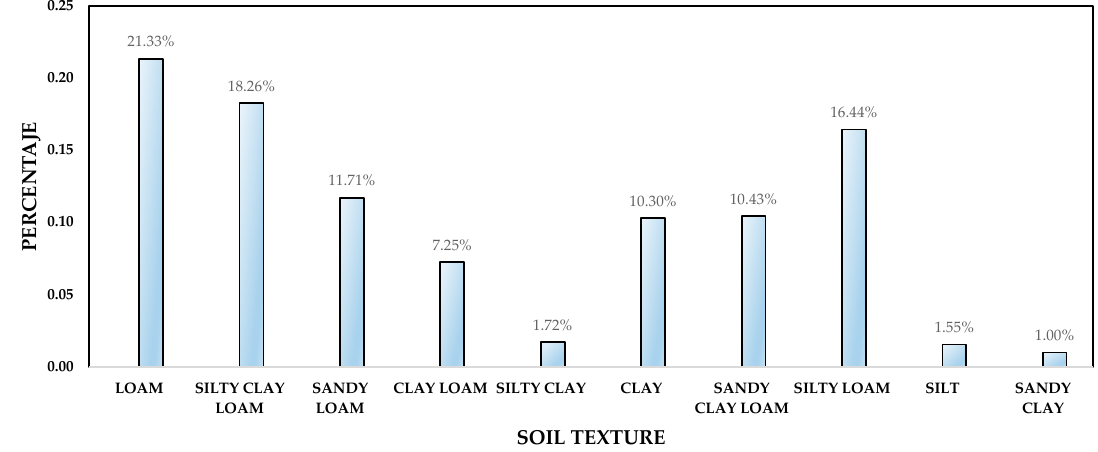
Figure 2. Soil textural classification in the studied areas.